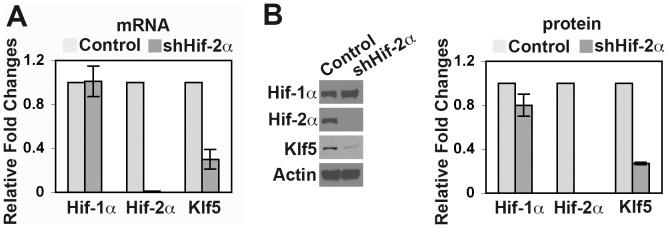
Suppression of Hif-2α reduces Klf5 expression in Hu-glioma cells.Hu-glioma cells expressing luciferase shRNA (control) or Hif-2α shRNA (shHif-2α) were subjected to hypoxia for 6hrs and analyzed for gene expression by RT-QPCR (A) and Western (B). Data are expressed as fold changes relative to shRNA controls.